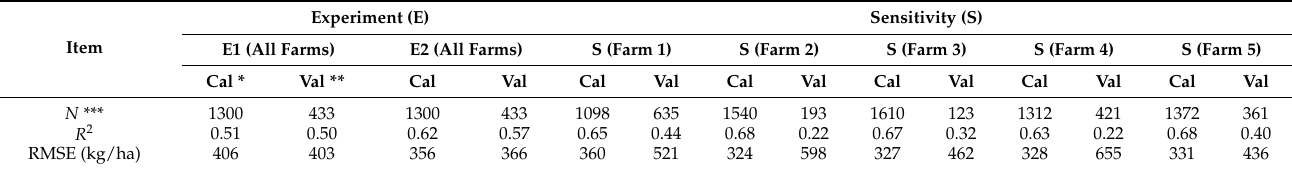
Figure 8. Observed vs. predicted biomass (kg/ha) for the calibration ( left ) and evaluation ( right ) from 8 the two experiment cases ( n is number of samples). Top: Experiment 1 (S2 imagery only). Bottom: Experiment 2 (S2 imagery and climate variables). Table 3. Summary of the model calibration, evaluation and sensitivity